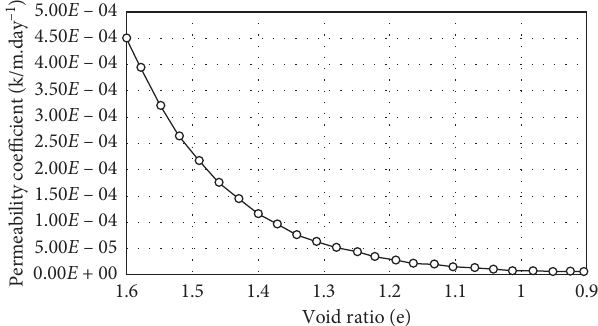
Figure 2: Relationship between permeability coefficient and void ratio of soft